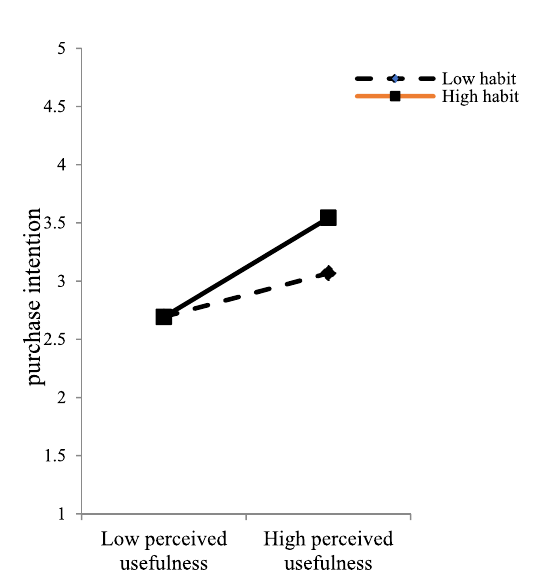
Fig. 2 Results of the moderating role of habit when perceived usefulness has high/low